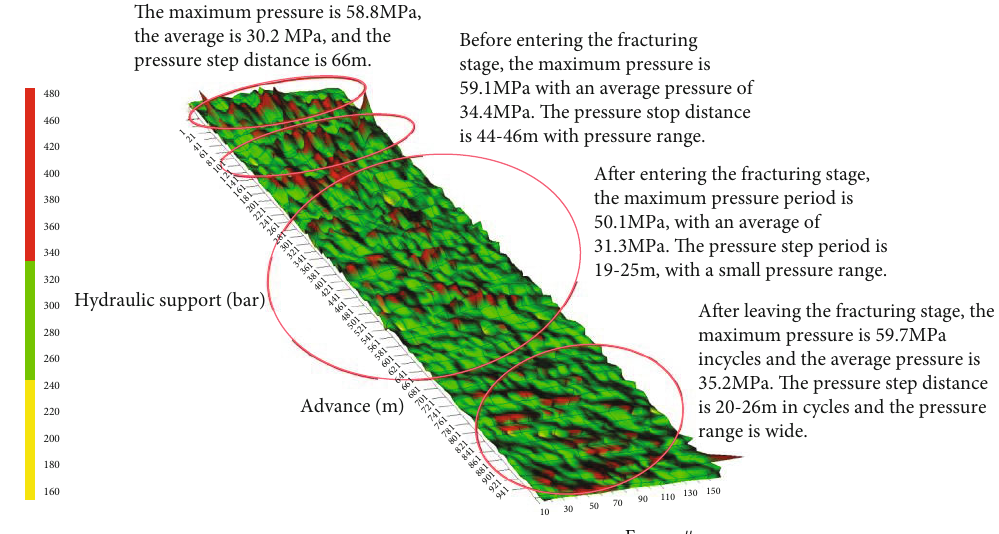
Figure 4: 3D variation characteristics of ore pressure.